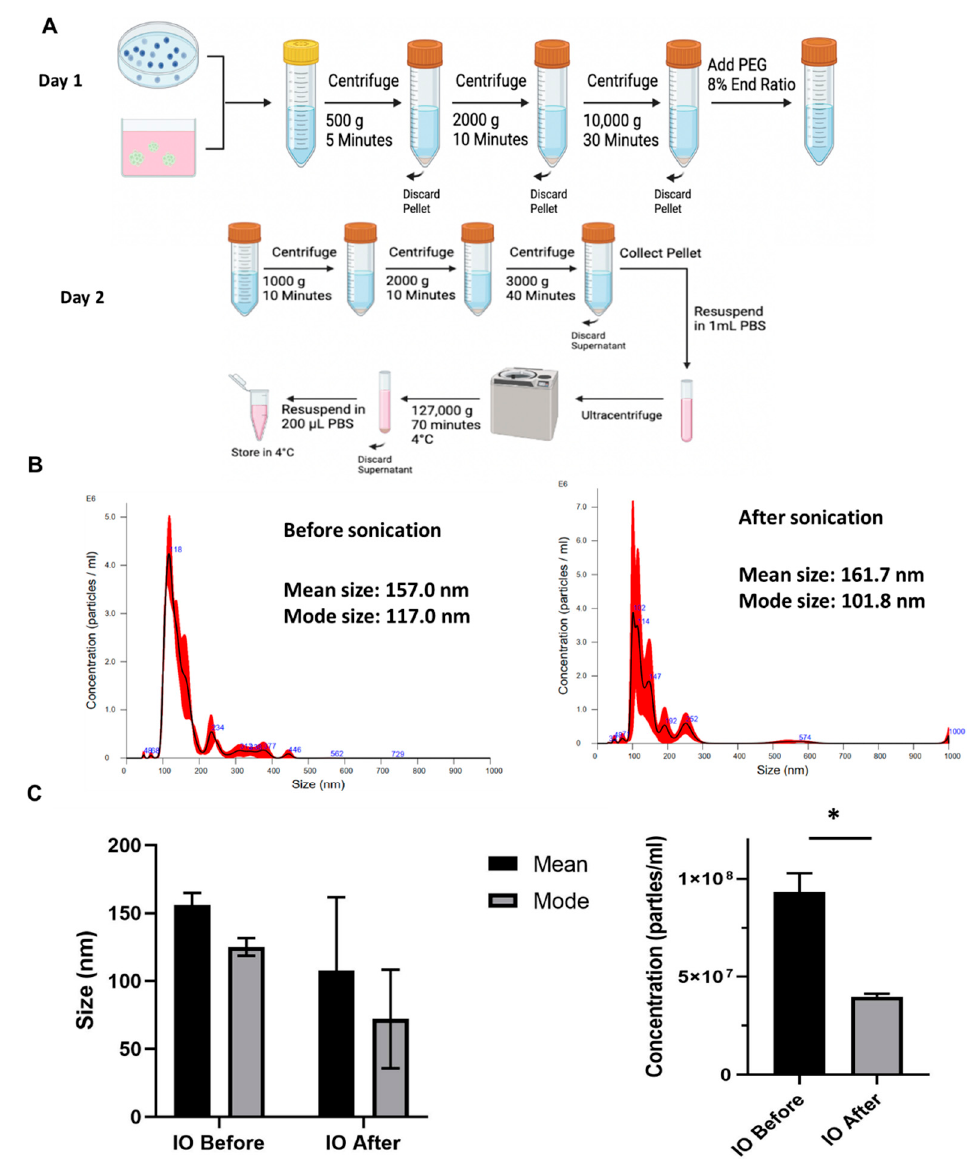
Figure 2. NTA for forebrain organoid-EV before and after sonication. ( A ) Schematic illustration of EV isolation by ExtraPEG method. The illustration was plot by Katelyn Sears. ( B ) Representative NTA EV size distribution, Before sonication; and after sonication. ( C ) EV size and concentration before and after sonication. * indicates p < 0.05.